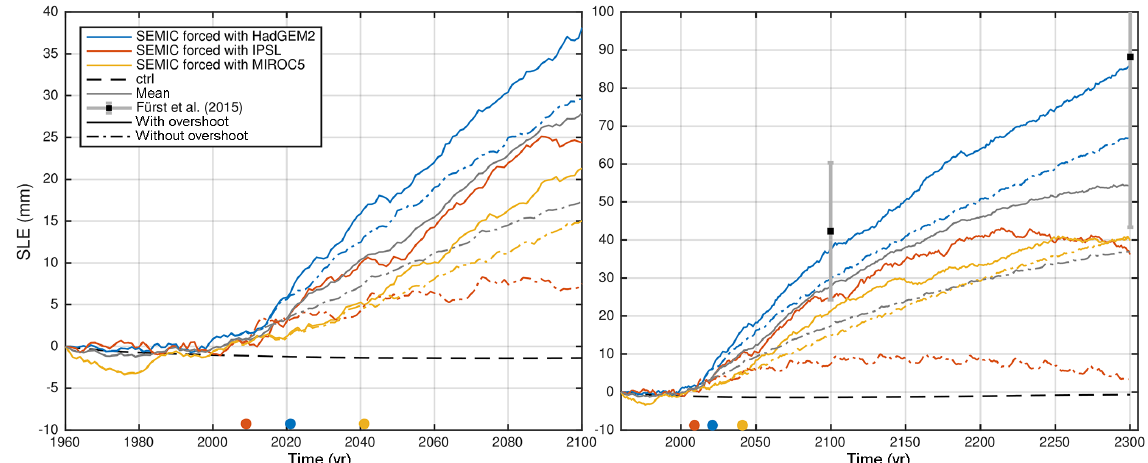
Figure 11. Sea-level equivalent (SLE, in millimetres) until the year 2100 (left panel) and 2300 (right panel) under RCP2.6 forcing (solid lines) and RCP2.6 forcing without overshoot (dotted-dashed). Additionally, the control run (black dashed line) and the model mean and RMS deviation from Fürst et al. (2015, Table B1) are shown. The coloured dots represent the onset years of overshooting 1.5 ◦ C in the global mean near-surface air temperature in a 30-year moving window relative to pre-industrial